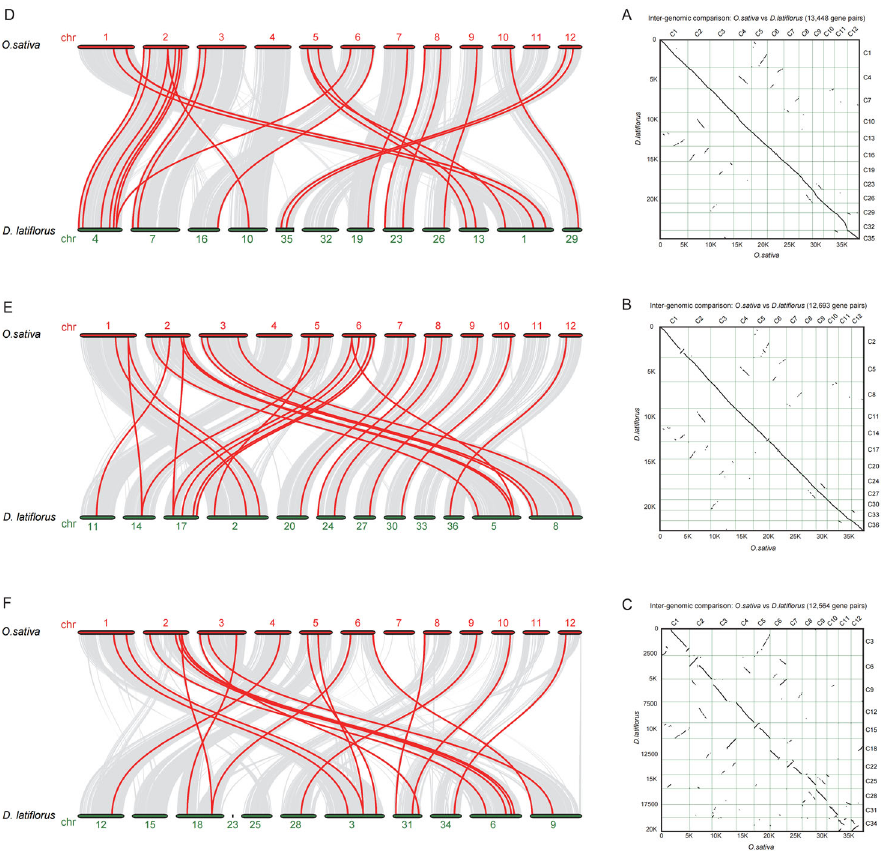
Figure 2. The synteny relationship between D. latiflorus and O. sativa . ( A – C ): MIKCc-type MADS-box Figure 2. T he synteny relationship between D. latiflorus and O. sativa . A - C: MIKCc-type MADS-box gene synteny between D. latiflorus subgenome A, B, C and rice. ( D – F ): genome synteny between gene synteny between D. latiflorus subgenome A, B, C and rice. D-F: genome synteny between subgenome A, B, C of D. latiflorus and O. sativa subgenome A, B, C of D. latiflorus and O. sativa .